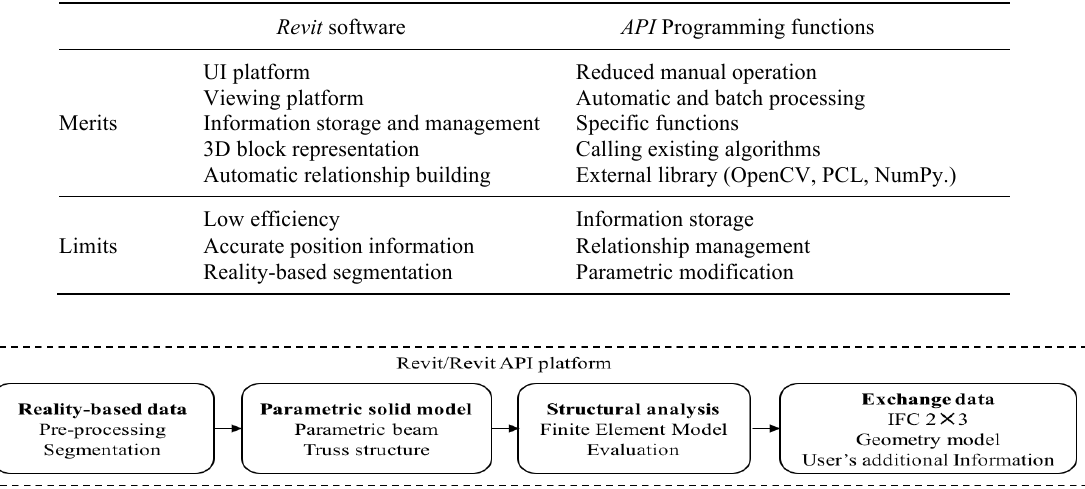
Figure 2. Uniform BIM environment for beam frame structure construction and